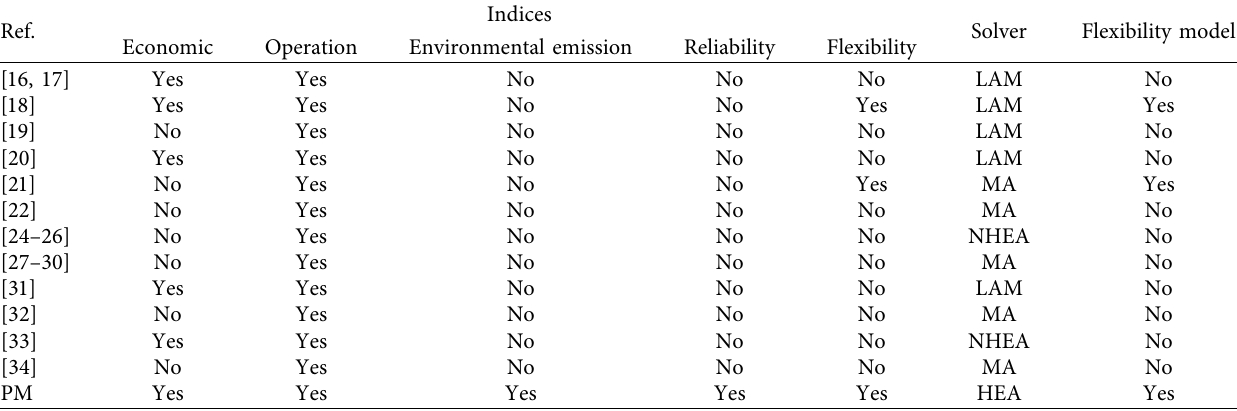
Table 1: A summary of the literature.